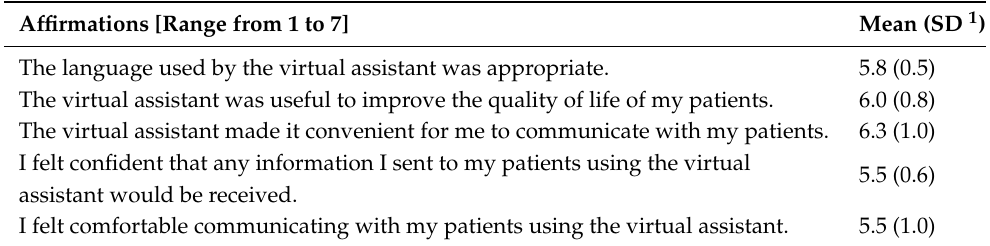
Table 7. Healthcare professionals’ responses regarding the virtual assistant utility.